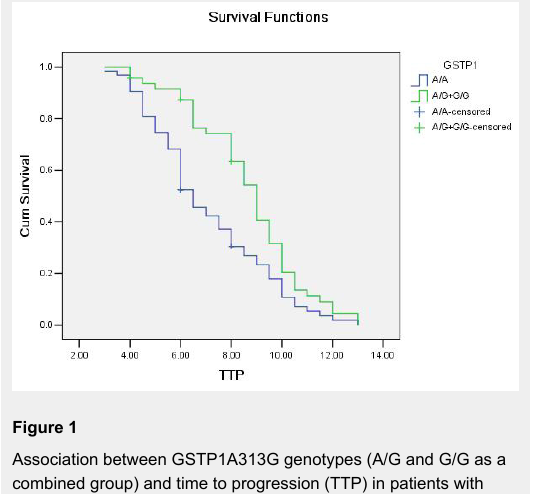
Association between GSTP1A313G genotypes (A/G and G/G as a combined group) and time to progression (TTP) in patients with advanced NSCLC receiving platinum-based chemotherapy. The vertical hash marks denote the time of last follow up for those patients lost to follow …up.